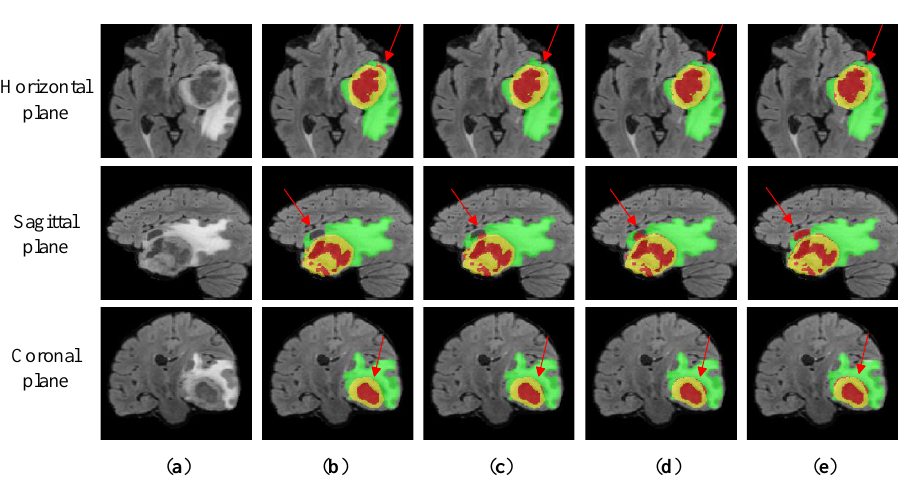
Figure 9. Segmentation results of the ablation experiment. ( a ) is the modality of Flair, ( b ) stands for HDC-Net, ( c ) stands for HDC + KSDC, ( d ) stands for HDC + KSDC + ACSF, ( e ) stands for ground truth. The yellow area is the enhancing tumor area. The red area is the necrotic and non-enhancing area. The green area is the peritumoral edema area.